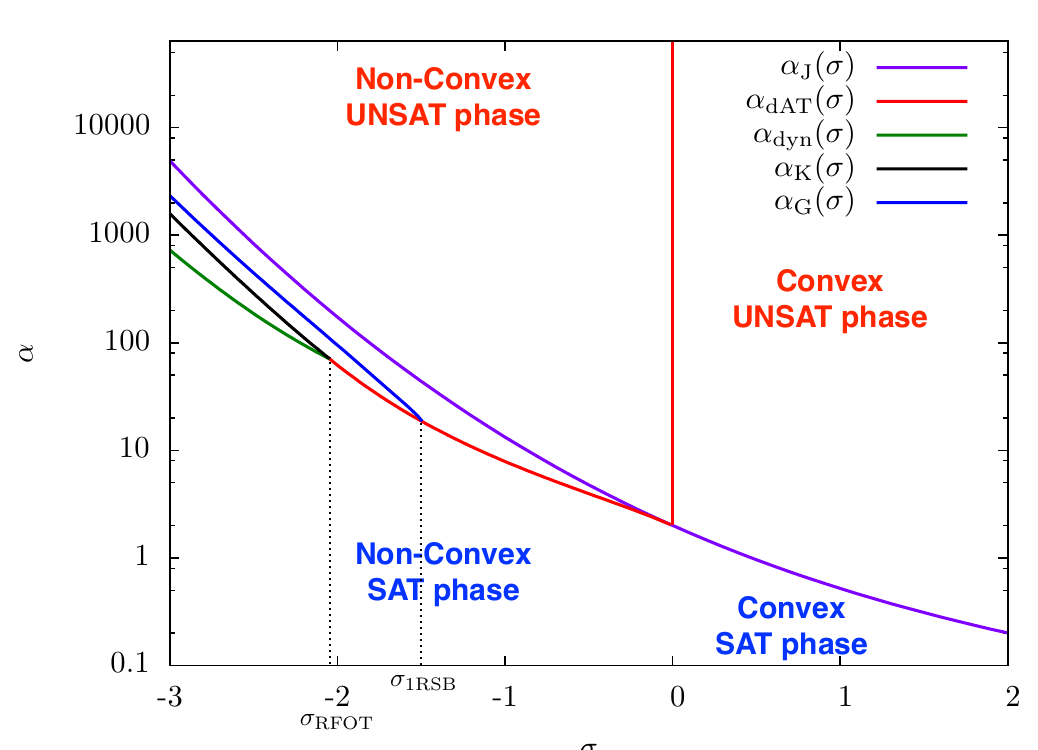
( σ ) is the jamming tran- J